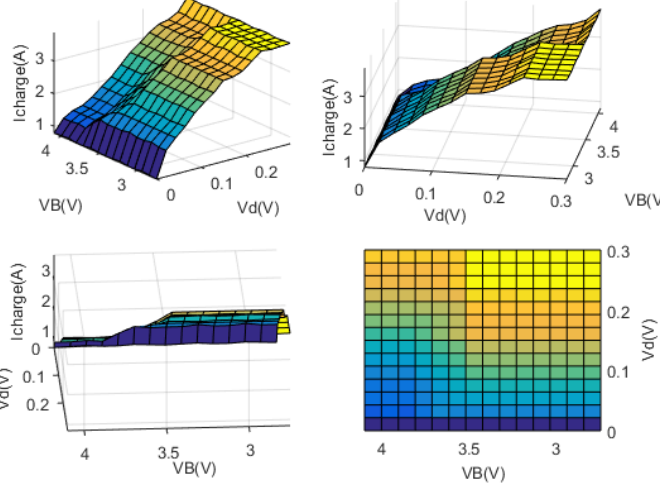
Figure 4. Output surface (I charge ) of the fuzzy logic controller according to V d and V B .